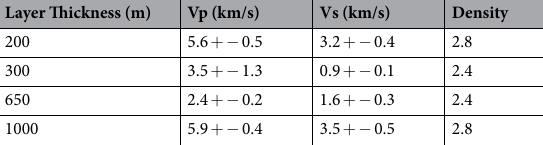
Table 1. 1D Velocity Model under GRA1, from Krüger (1994).